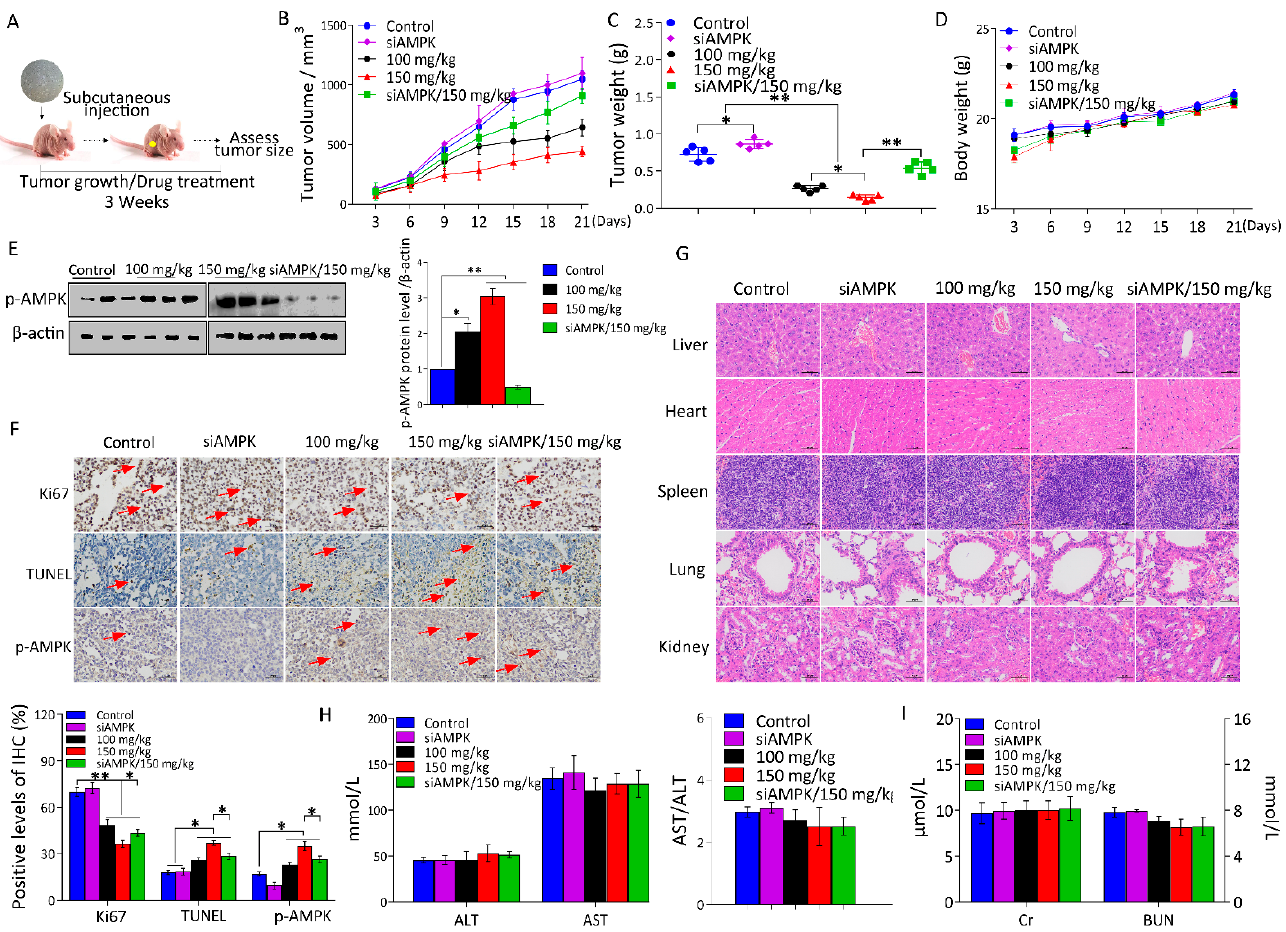
Figure 5. L-THP reduces the liver tumor growth by activating AMPK in vivo. ( A ) Flow chart of L-THP treated-BALB/c nude mice. ( B – D ) The tumor volumes, tumor weights, and body weights of the nude mice treated with or without L-THP were analyzed. ( E ) Western blotting using the lysates of isolated tumors and the indicated antibodies. ( F ) The expression levels of Ki67 and p-AMPK in the tumor tissues were detected by IHC and apoptosis was measured by TUNEL staining. Scale bar = 50 µm. ( G ) H&E staining was used to observe the histomorphology of the liver, heart, spleen, lung, and kidney tissues. Scale bar = 50 µm. ( H , I ) The serum levels of ALT, AST, Cr, and BUN in the mice from each group were detected. Scale bar equals to 100 µm. * p < 0.05 and ** p < 0.01 are considered to be statistically significant compared to the control.